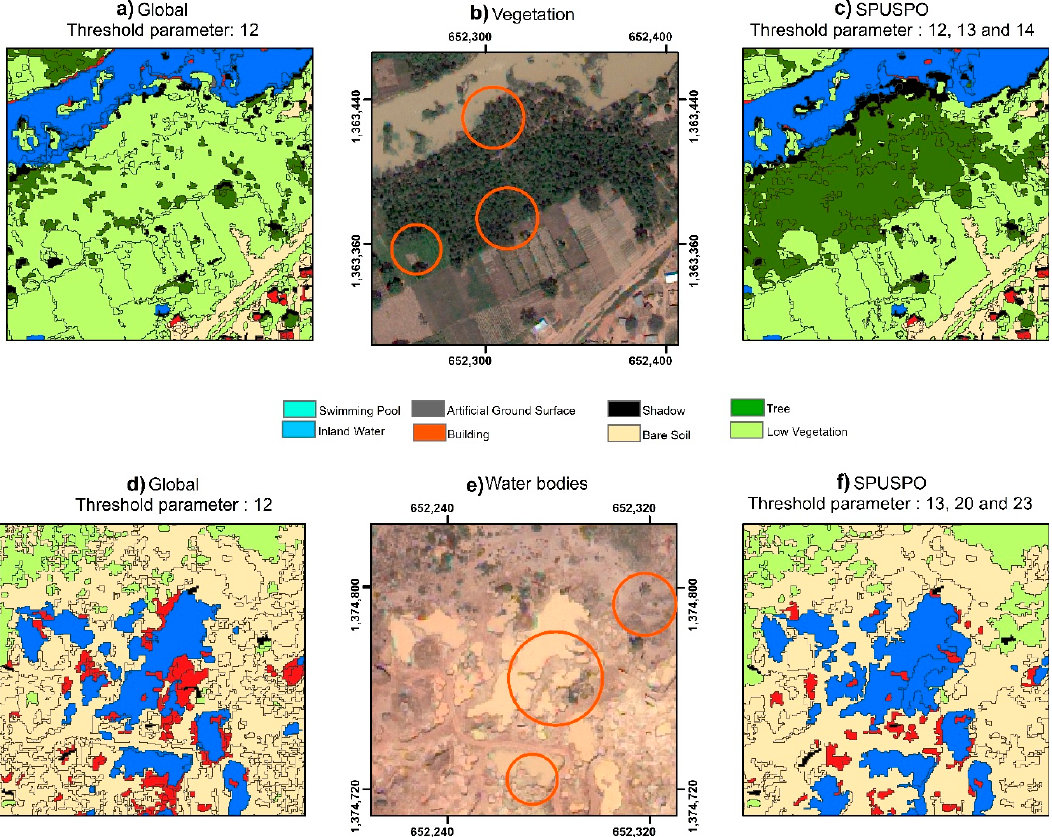
Figure 10. Example of the LULC map classification in a vegetated regions and inland water bodies. ( a ) LULC classification with a global approach in a forested area, ( b ) RGB Pleiades Composite, ( c ) LULC classification with a cutline approach in a forested area, ( d ) LULC classification with a global approach in water bodies, ( e ) RGB Pleiades Composite, and ( f ) LULC classification with a cutline approach in water bodies.